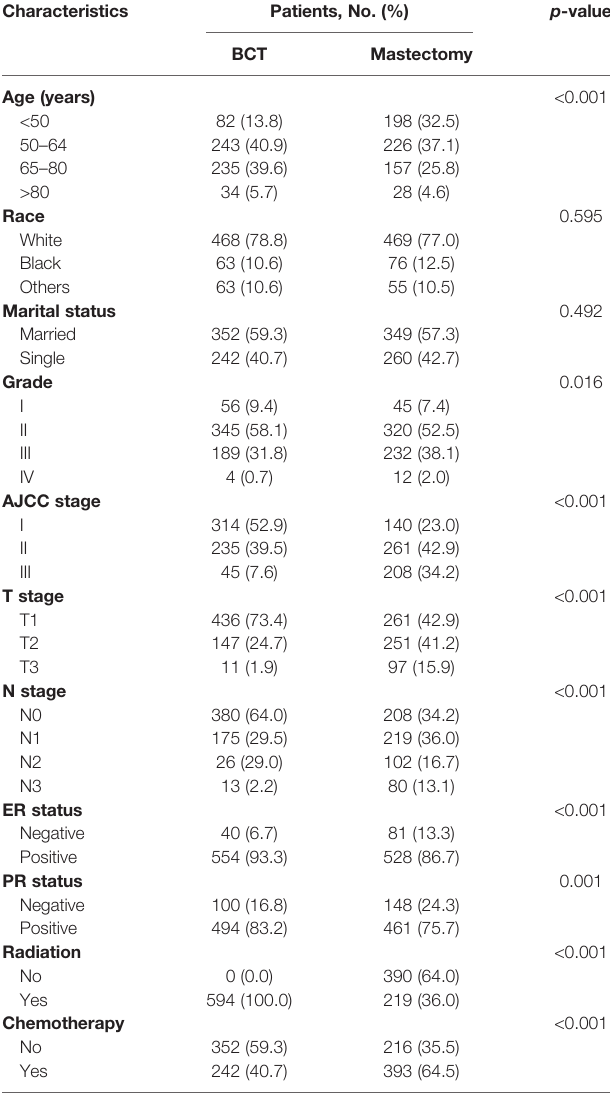
TABLE 1 | Comparison of baseline characteristics of early-stage IMPC between BCT and mastectomy groups. Characteristics